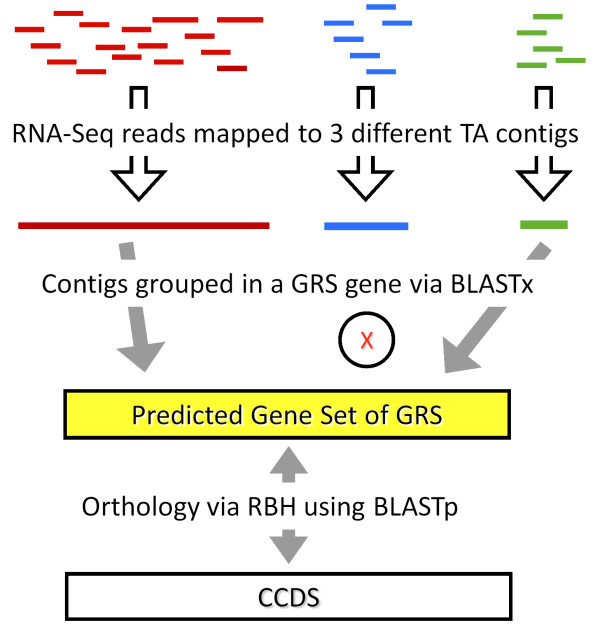
Overview of the non-model species RNA-Seq mapping strategy for inferring ‘gene’ grouping of RNA-Seq read data. Displayed are RNA-Seq reads that are mapped to three different TA contigs. The red and green contigs (DNA) are assigned to the same gene of the GRS (protein) via BlastX. However, due to divergence between the target species and the genomic reference species (GRS), the blue contig is not, resulting in only the red and green RNA-Seq reads being assigned to this GRS ortholog. In order to compare the expression data inferred from these GRS groupings to that obtained by directly mapping RNA-Seq reads to the CCDS genes, the orthology between GRS and CCDS genes was determined using the Reciprocal Best Hit (RBH) via BLASTp. This method can be compared to the method outlined in Figure 5b.